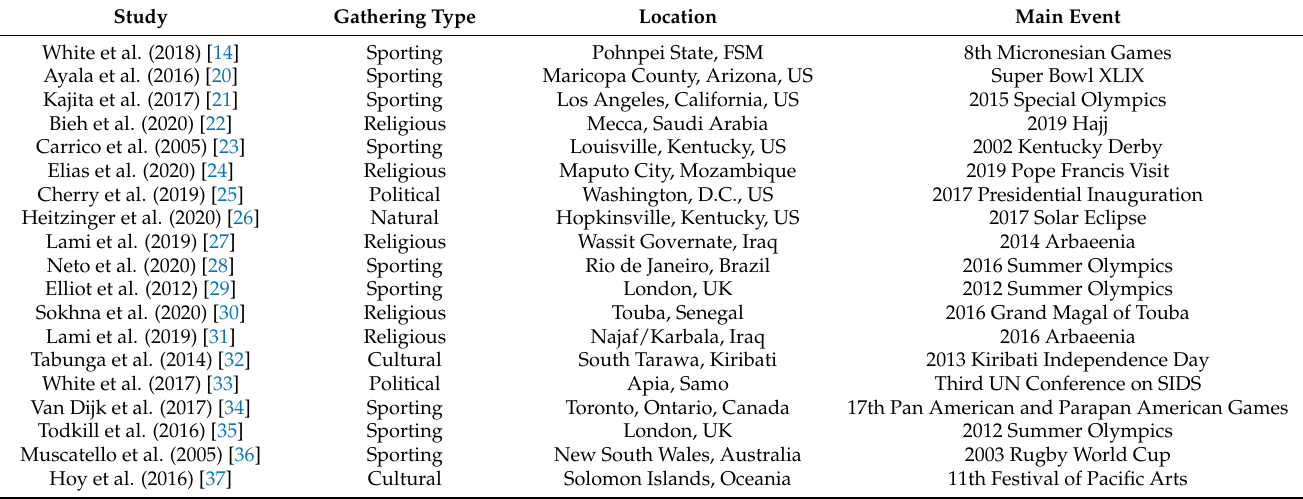
Table 1. Mass gatherings.